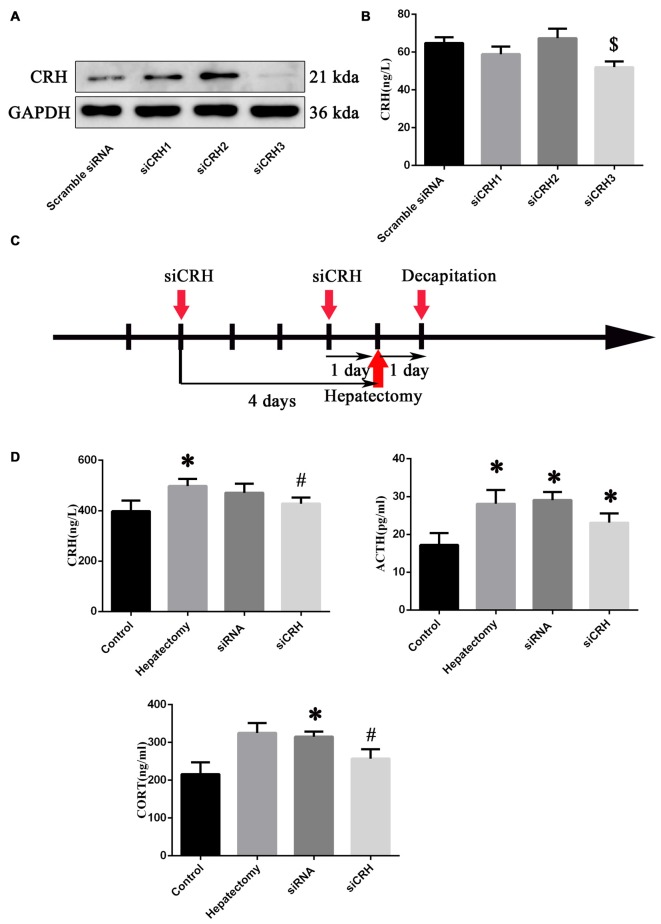
The effect of endogenous CRH knock down on the serum CRH, ACTH and CORT levels of rats at 1 day after hepatectomy. Representative bands (A) in primary hypothalamus neurons after culture with siRNAs (n = 3) and quantification of the CRH secretion level (B) from primary hypothalamus neurons (n = 6) $vs. scramble siRNA group (p < 0.05). The injection and decapitation time (C) of siRNA administration. (D) Blood CRH, ACTH and CORT levels among the control, hepatectomy, siRNA and siCRH groups. The data are presented as the mean ± SD (n = 5) *vs. control group (p < 0.05); #vs. hepatectomy group (p < 0.05).